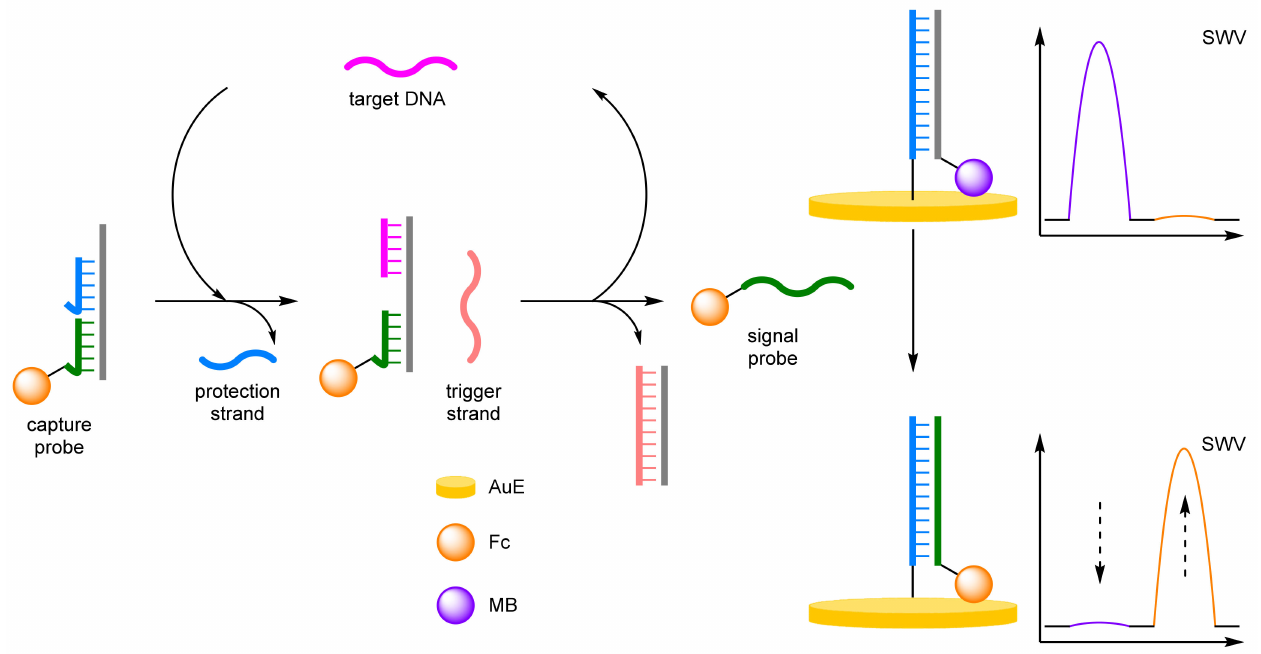
Figure 19. Schematic representation of toehold mediated strand displacement